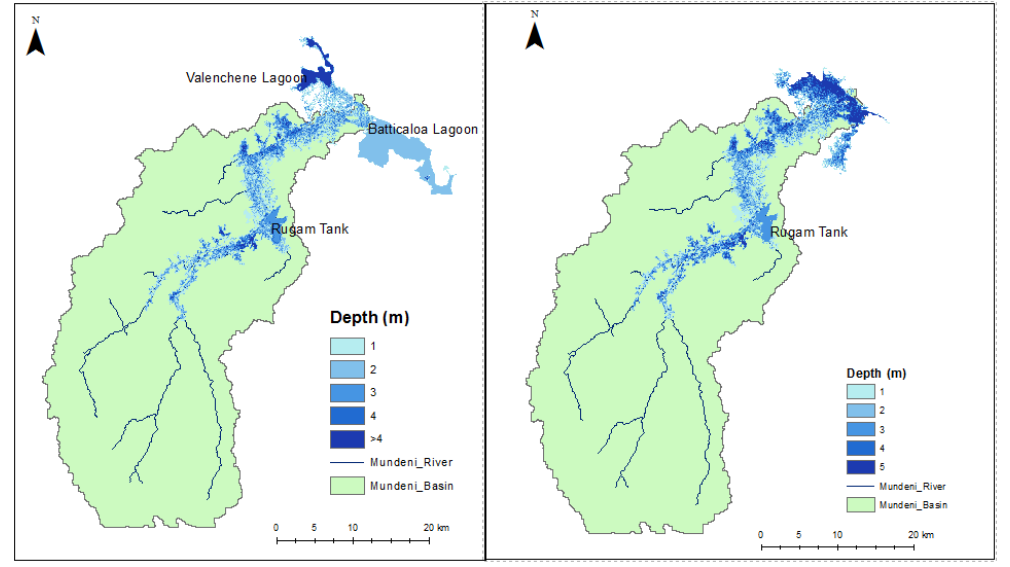
Figure 4. Flood extent maps based on 30m DEM (left) and 90m DEM (right) in the Mundeni Aru River Basin.